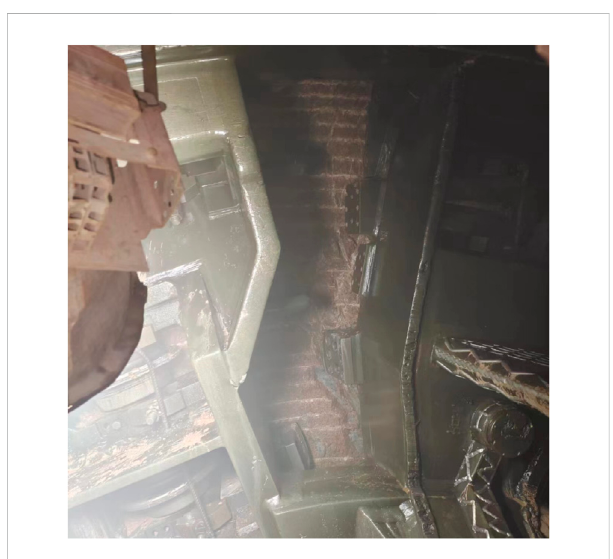
FIGURE 8 Tunnel surface of the 205th ring in the Shanwu tunnel